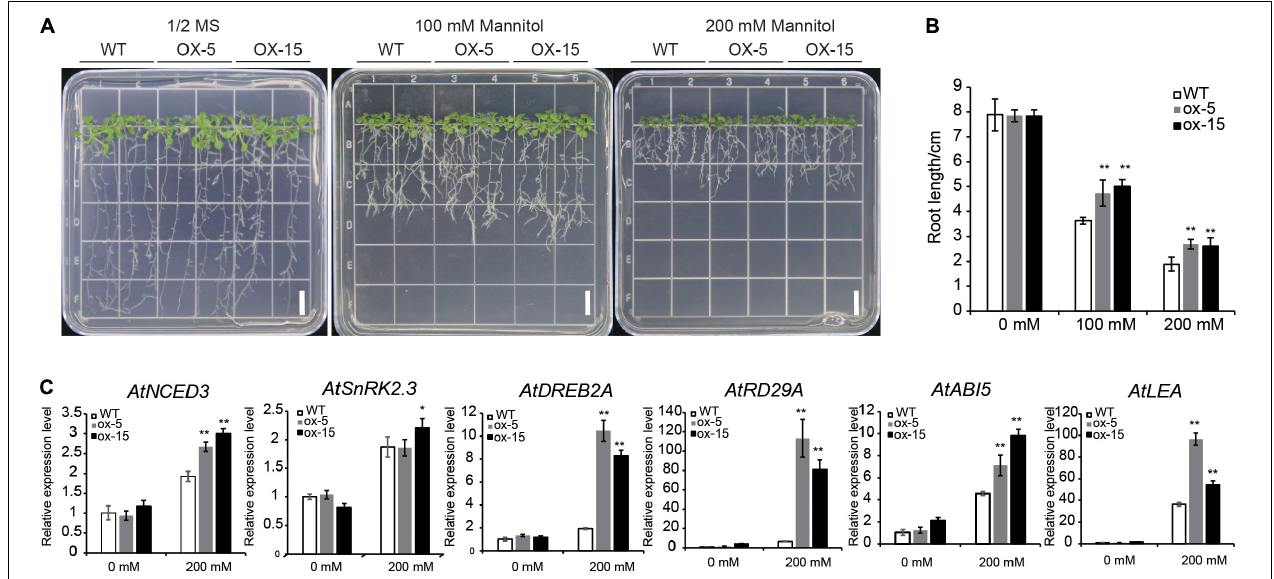
FIGURE 8 | Overexpression of BdGATA13 enhanced tolerance to drought stress in Arabidopsis seedlings. (A) 5-day-old of seedlings of Arabidopsis were grown in 0, 100, and 200 mM mannitol for 10 day; bars = 1 cm. (B) Primary root lengths of WT and transgenic lines. (C) qRT-PCR results for six drought-related genes under 0 and 200 mM mannitol. Values are means ± SD ( n = 3). Asterisks represent statistically significant differences between the indicated samples. Student’s t -tests: * P ≤ 0.05, ** P ≤ 0.01.